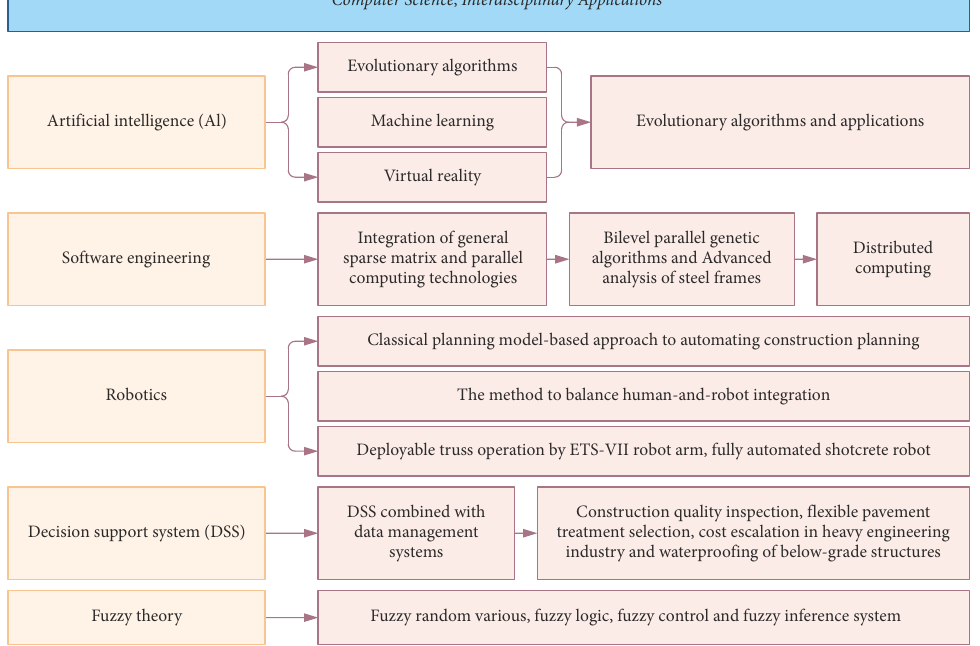
Figure 16. Publications related to Computer Science , Interdisciplinary